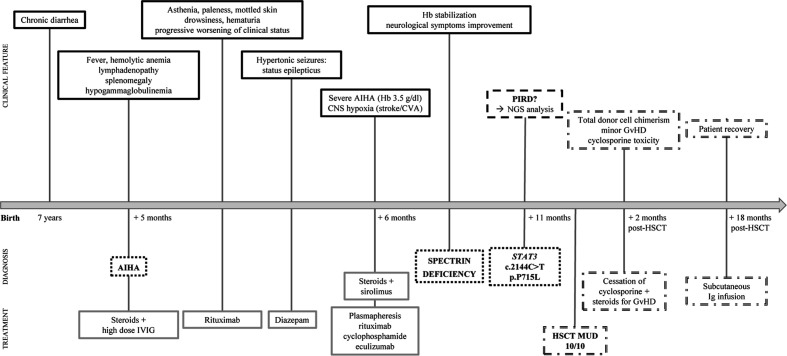
Timeline of patient’s clinical presentation, diagnosis and treatment. Clinical features (solid black lines), diagnosis (black dotted lines), treatment (solid gray lines), hypothesis (dashed black lines) and hematopoietic stem cell transplantation (HSCT) outcome (double dashed lines) are indicated.